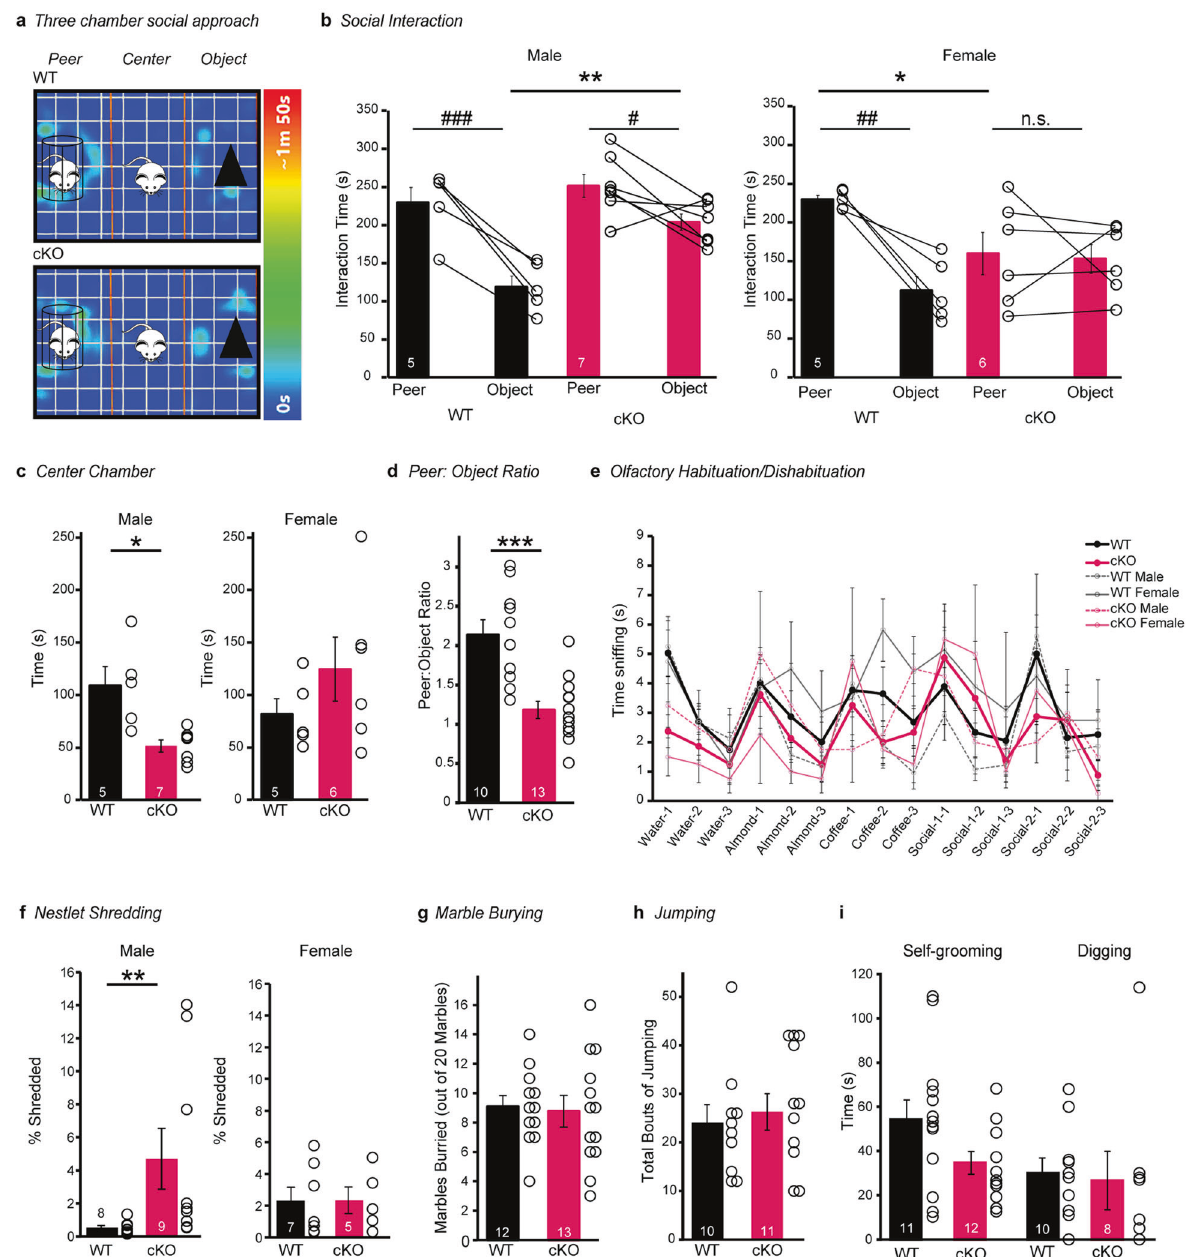
Fig. 2 Nrxn2 cKO mice exhibited a sex-dependent preference for social cues and increased nestlet shredding behavior. a – e Nrxn2 cKO mice exhibited a sex-dependent preference for social cues in the three-chamber social approach test with intact olfactory function. a Representative heat maps of the three-chamber social approach test. b Summary graphs of time spent with peers and objects. c Summary graphs of time spent in the center chamber. d Summary graph of peer: object ratio. e Summary graph depicting time spent snif fi ng water, non-social odors (almond extract and coffee), and social odors in the olfactory habituation/dishabituation test. f – i Nrxn2 cKO males, and not females, exhibited increased nestlet shredding behavior. Both sexes exhibited no changes in other repetitive behaviors measured. f Summary graphs of % nestlet shredded. g – i Summary graphs of number of marbles buried ( g ), total bouts of jumping ( h ), and time spent self-grooming and digging ( i ). Number of mice is listed inside the bar graphs. Each open circle in the summary graphs represents each mouse. Data is represented as means ± SEM from 5 male WT, 7 male Nrxn2 cKO, 5 female WT and 6 female Nrxn2 cKO mice for ( b , c ); 10 WT and 13 Nrxn2 cKO for ( d ); 4 male WT and 4 Nrxn2 cKO, 5 female WT and 4 female Nrxn2 cKO for ( e ). 8 male WT, 9 male Nrxn2 cKO, 7 female WT and 5 female Nrxn2 cKO for ( f ); 12 WT and 13 Nrxn2 cKO for ( g ); 10 WT and 11 Nrxn2 cKO for ( h ); 11 WT and 12 Nrxn2 cKO for self-grooming ( i ); 10 WT and 8 Nrxn2 cKO for digging ( i ). Data is collected from two independent cohorts of mice for panels ( f , g ) and ( h , i ). Statistical assessments were performed by RM two-way ANOVA followed by Sidak ’ s post hoc test ( b , e ) or two-tailed Student ’ s t -test ( c , d , g – i ) or Mann – Whitney test ( f ) by comparing Nrxn2 cKO to WT with n.s. = not signi fi cant * p < 0.05, ** p < 0.01, *** p < 0.001, **** p < 0.0001 and by comparing interaction time with peer and object within each genotype with # p < 0.05, ## p < 0.01, ### p < 0.001.